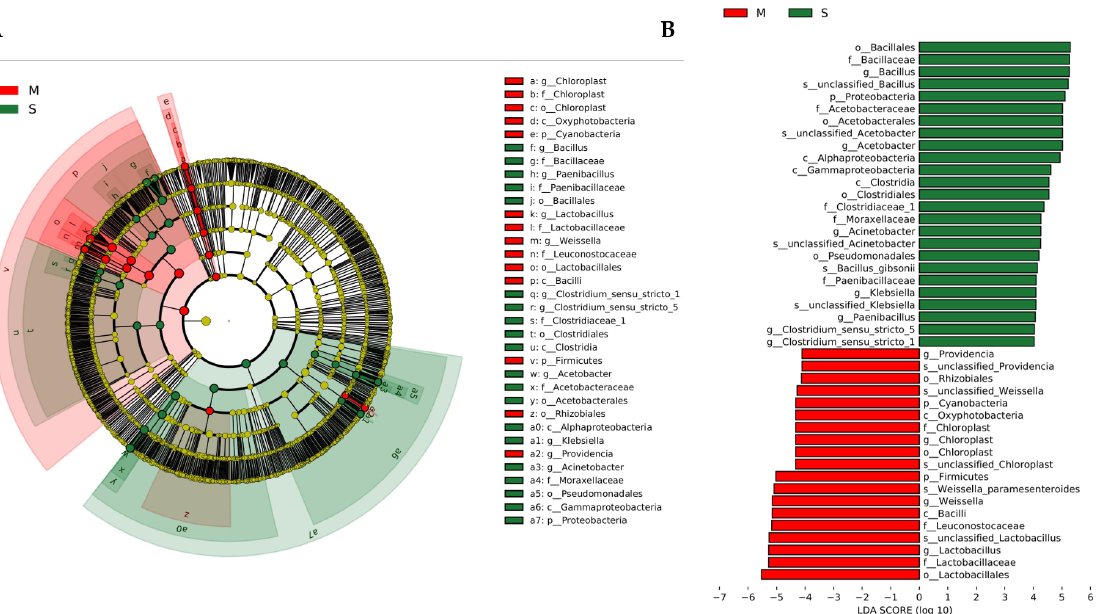
Figure 5. Relative abundance of bacteria at the phylum level ( A ) and genus level ( B ). S: monoculture of soybean; M: monoculture of maize; MS1, MS2, and MS3 mean different row ratios of maize and soybean intercropping (1:1, 1:3, and 1:5).